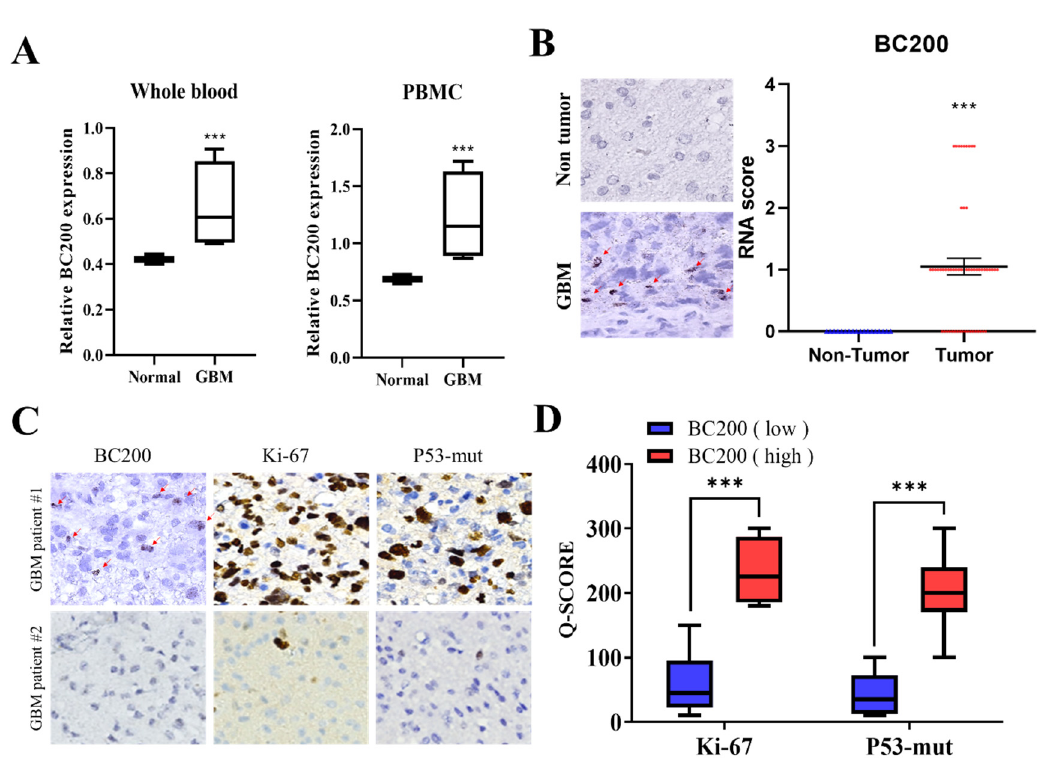
Figure 1. Expression level of full-length BC200 RNA in the blood and tissue. ( A ) Whole blood or PBMC from healthy participants and GB patients were assessed using RT-qPCR. GAPDH was used as the endogenous control. ( B ) The differential expression of BC200 in GB samples ( n = 48) and adjacent normal tissues ( n = 15) is shown. ( C , D ) The differential expression of Ki-67 and p53-mut in GB patients ( n = 48) with a high or low expression of BC200 RNA. *** p < 0.001.